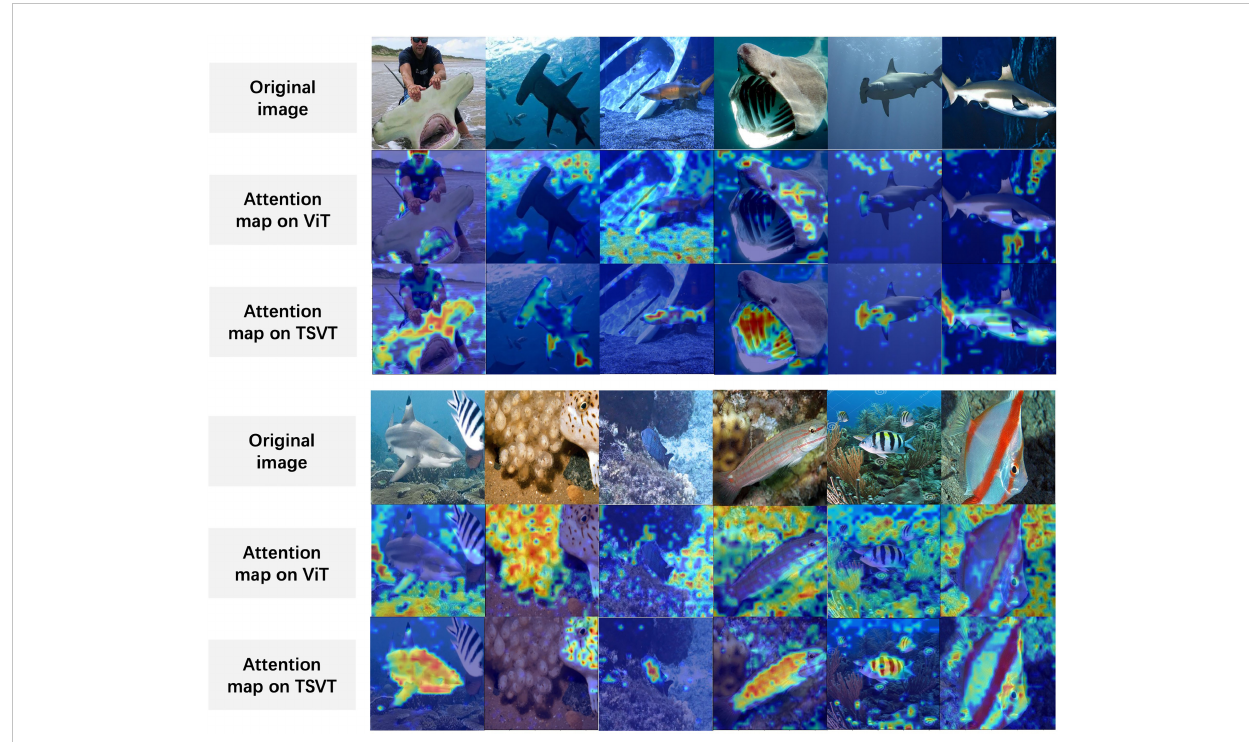
FIGURE 3 Visualization results on marine biological datasets, in which the fi rst and fourth rows are six images in Sharks and WildFish datasets, the second and fi fth rows are visualization of six images in the two datasets on ViT, and the third and sixth rows are visualization on